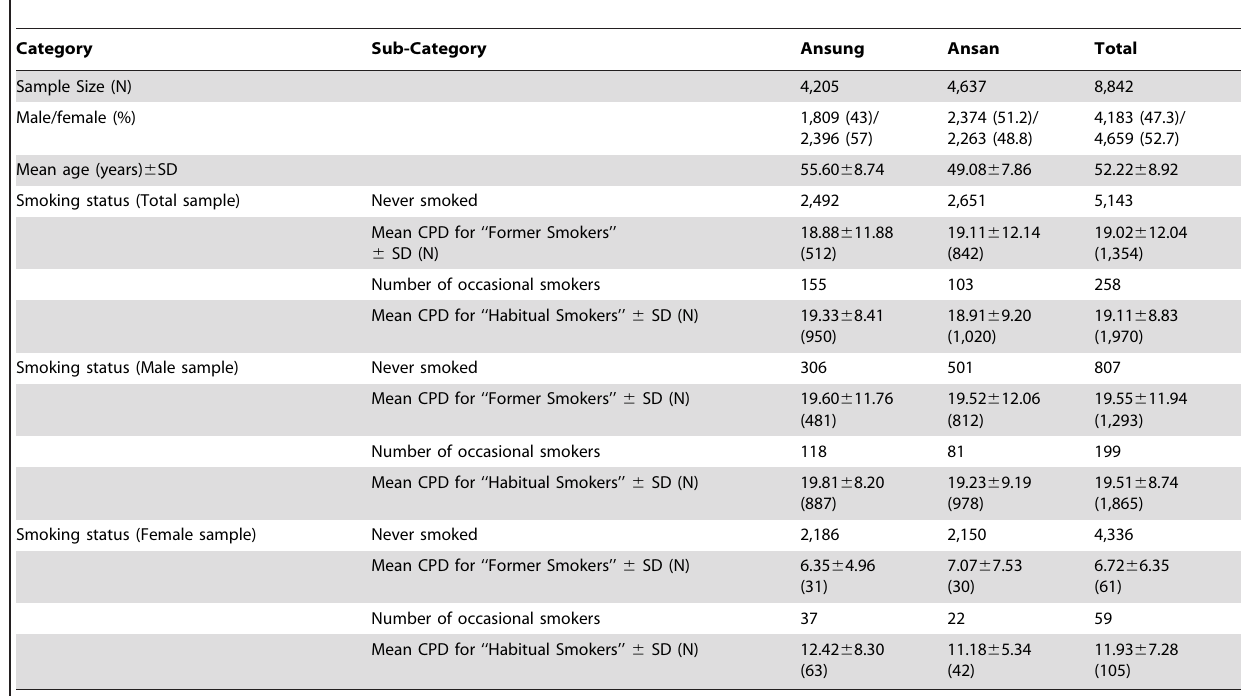
Table 1. Demographic characteristics of study